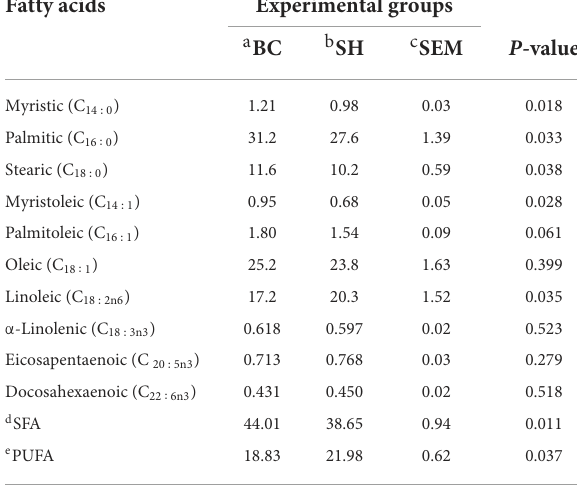
Fatty acids Experimental